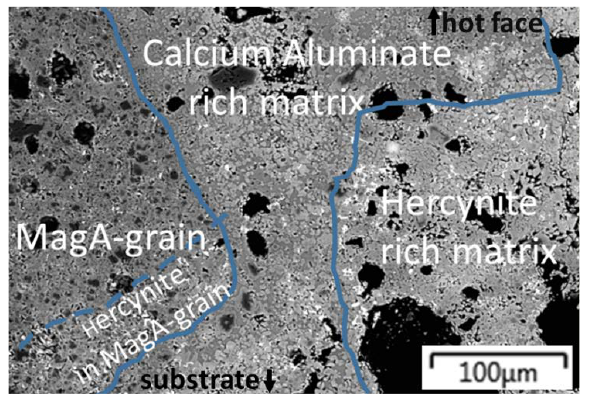
Figure 13. Microstructure close to the interface with the substrate. Table 6. XRD-phase analyses of the different zones of MagA-gun.